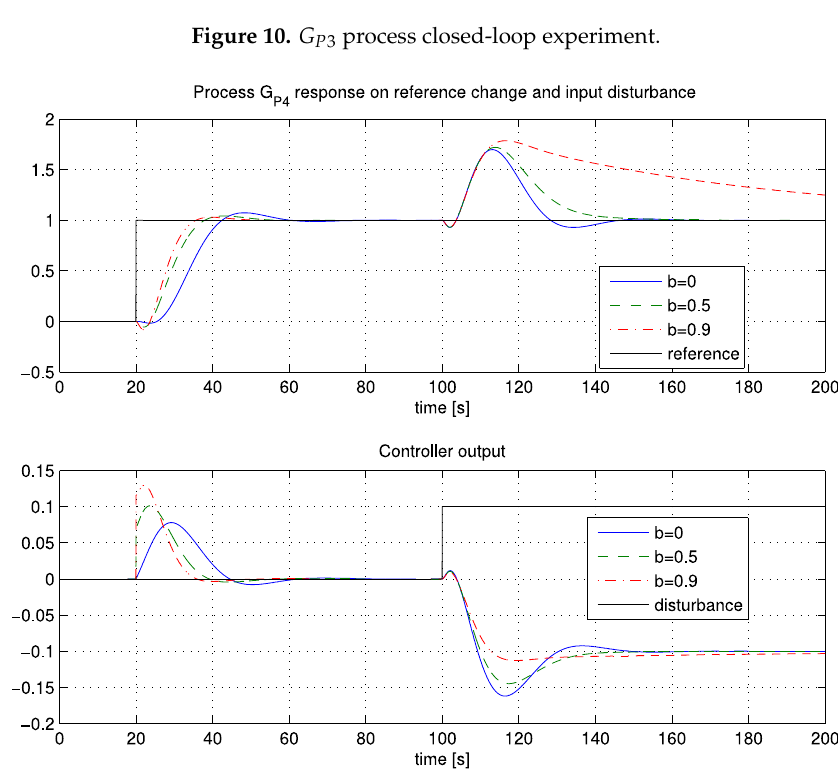
Figure 11. G P 4 process closed-loop experiment.